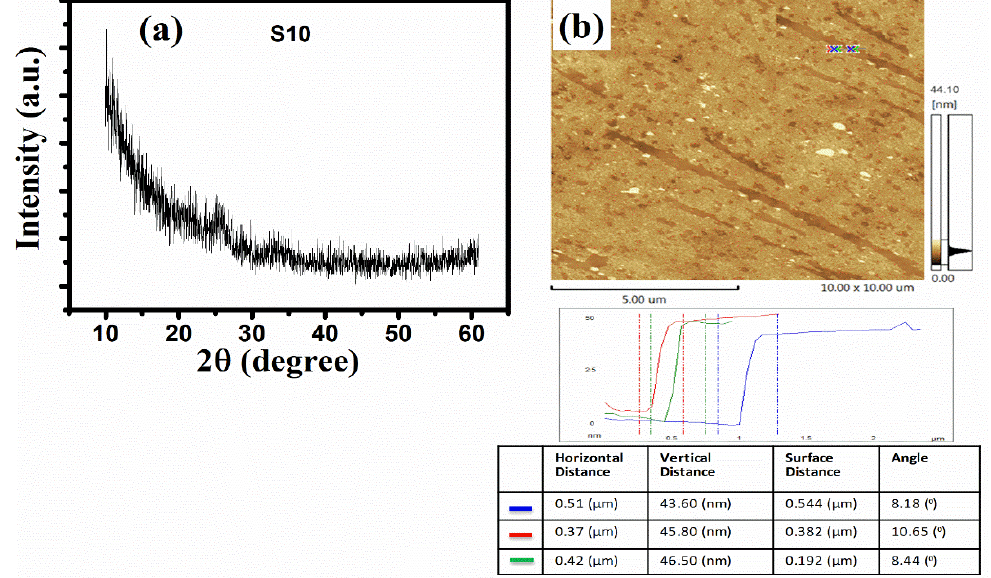
Figure 3. (a) XRD pattern; (b) AFM spectra, of the sample a-carbon film.